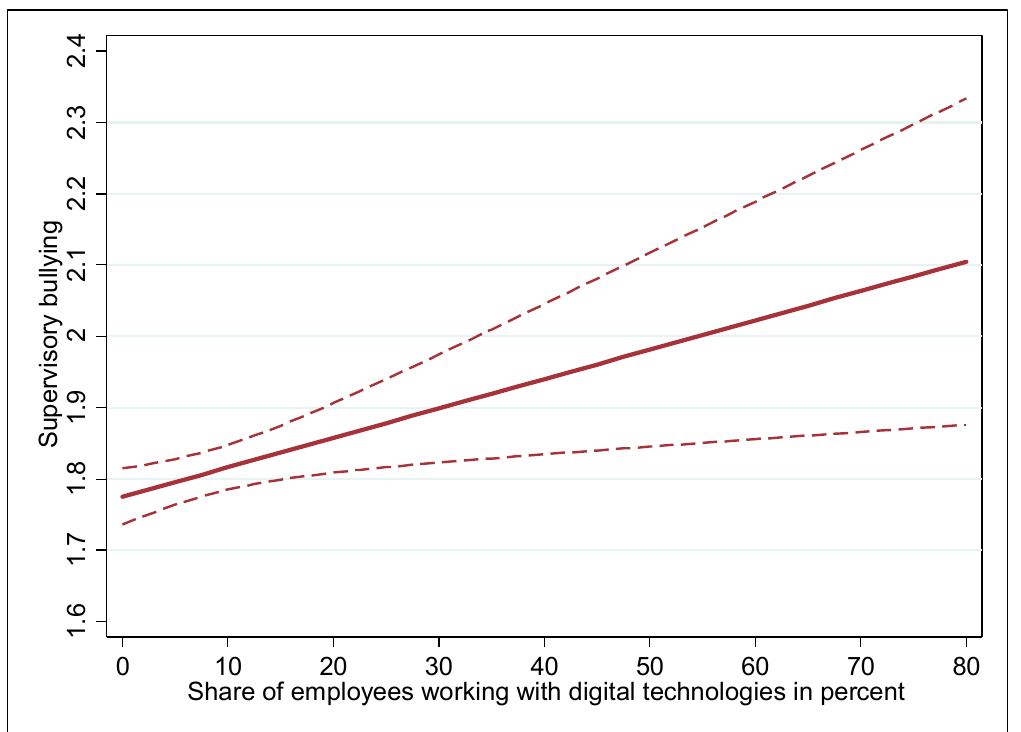
Figure 2. The influence of the workplace level shares of employees working with digital work on supervisory bullying for employees with high school degrees, with 95% confidence bands (workplace level random-effects regressions displayed in Table 3).